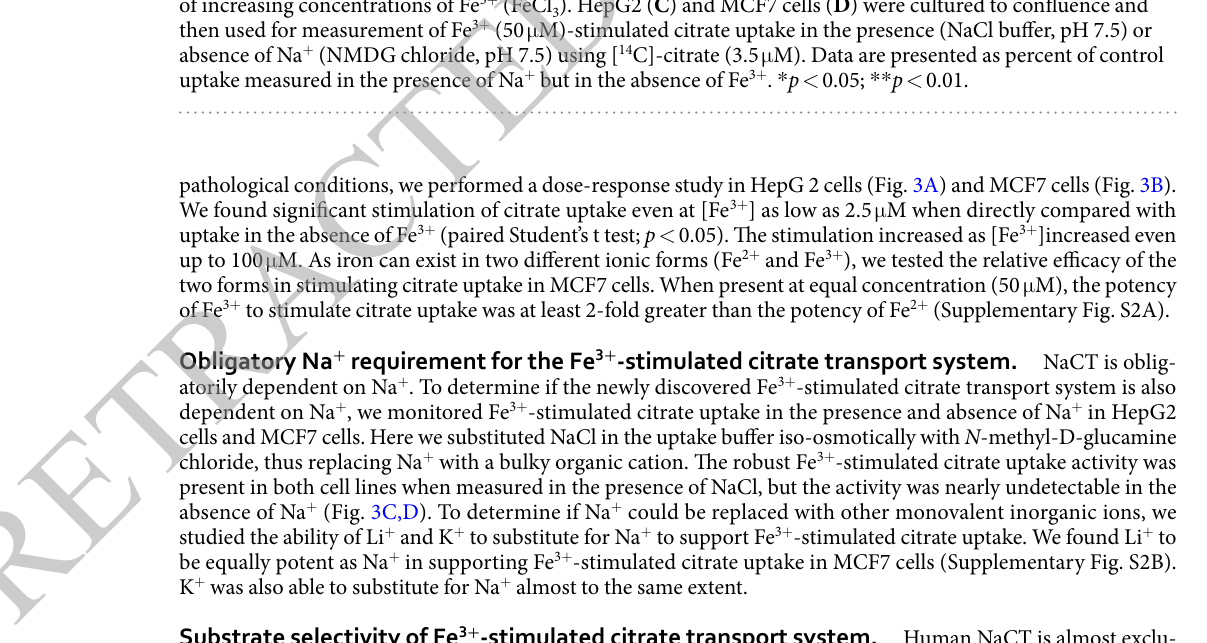
Figure 3. Fe 3 + dose-response for stimulation for citrate uptake and the Na + -dependence of the uptake process in HepG2 cells and MCF7 cells. HepG2 ( A ) and MCF7 cells ( B ) were cultured to confluence and then used for measurements of [ 14 C]-citrate (3.5 μ M) uptake (NaCl buffer, pH 7.5; 15 min incubation) in the presence of increasing concentrations of Fe 3 + (FeCl 3 ). HepG2 ( C ) and MCF7 cells ( D ) were cultured to confluence and then used for measurement of Fe 3 + (50 μ M)-stimulated citrate uptake in the presence (NaCl buffer, pH 7.5) or absence of Na + (NMDG chloride, pH 7.5) using [ 14 C]-citrate (3.5 μ M). Data are presented as percent of control uptake measured in the presence of Na + but in the absence of Fe 3 + . * p < 0.05; ** p <